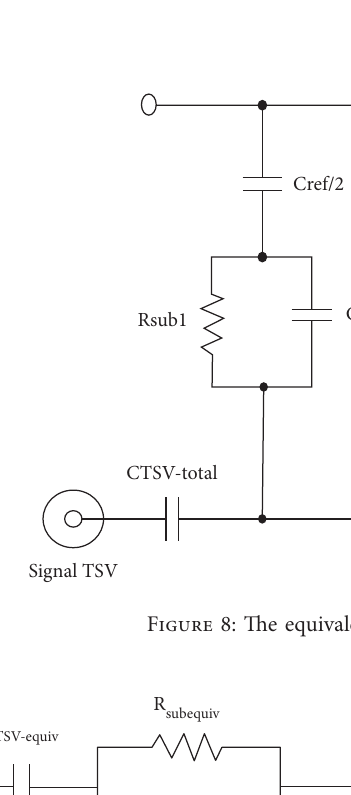
Figure 7: Structure of the TSV-active circuit noise coupling.